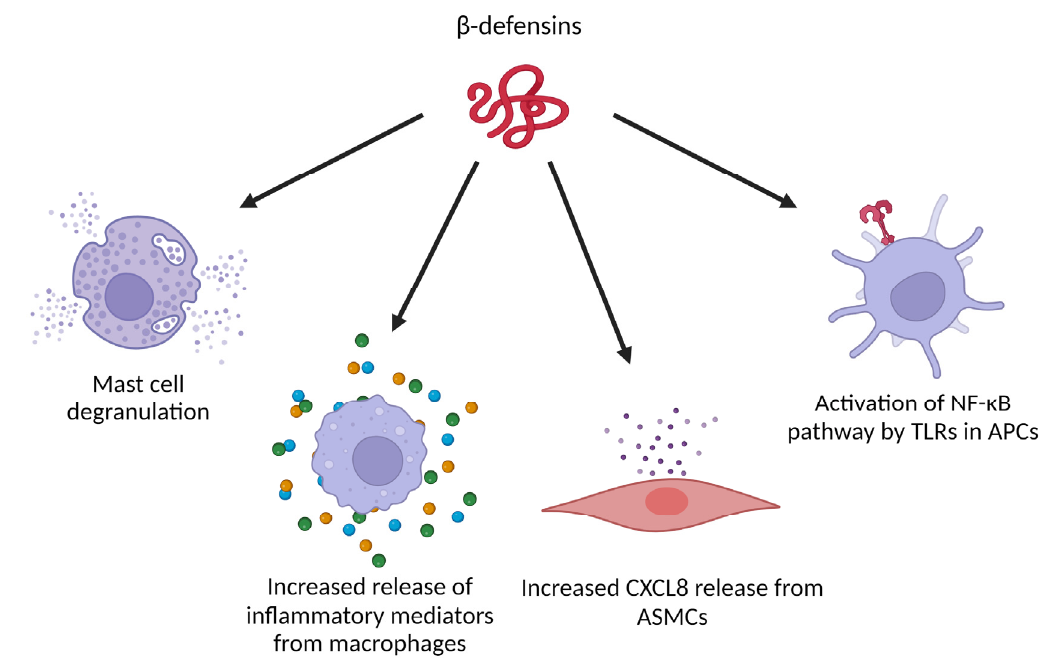
Figure 5. Immune-related activities of β -defensins that can be relevant in the tumor microenvi- ronment. (ASMCs: airway smooth muscle cells, APCs: antigen presenting cells). Created with BioRen- der.com.